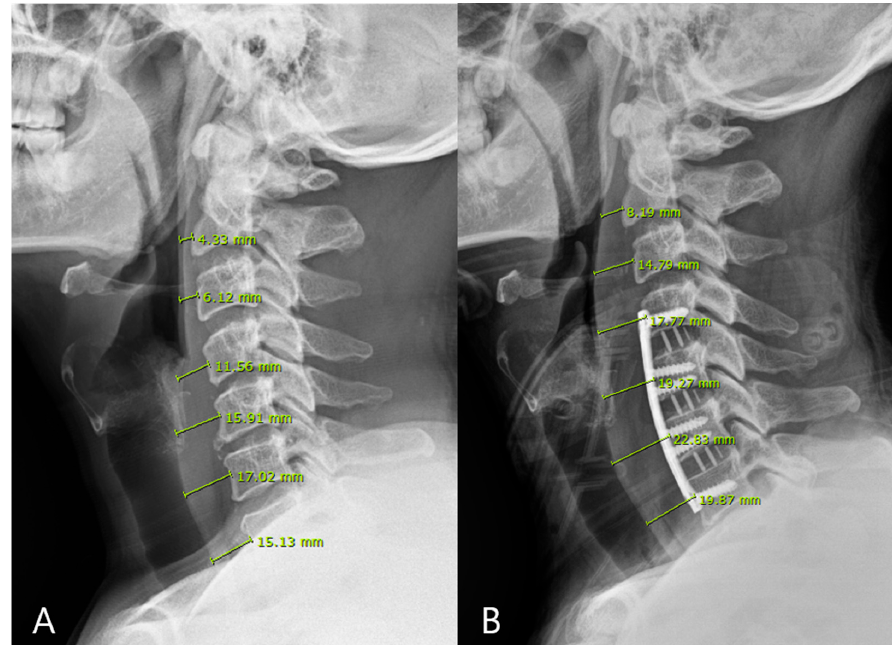
Figure 4. Prevertebral soft tissue swelling (PSTS) was calculated from the C-spine lateral radiographs. The sum of total variation in PSTS at each level from C2 to C7 was used to evaluate the relationship between PSTS and degree of dysphagia. ( A ) is preoperative PSTS at each level and ( B ) is postoperative PSTS at each level.